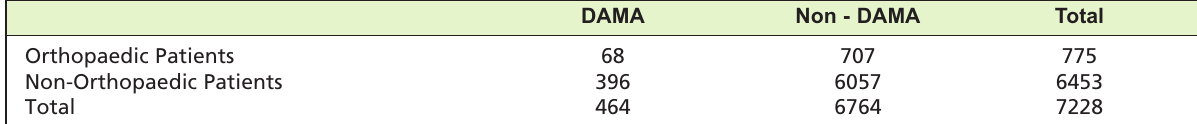
Single Table Analysis of Total Patients going discharge against medical advise versus Total Patients not going Table III: discharge against medical advise